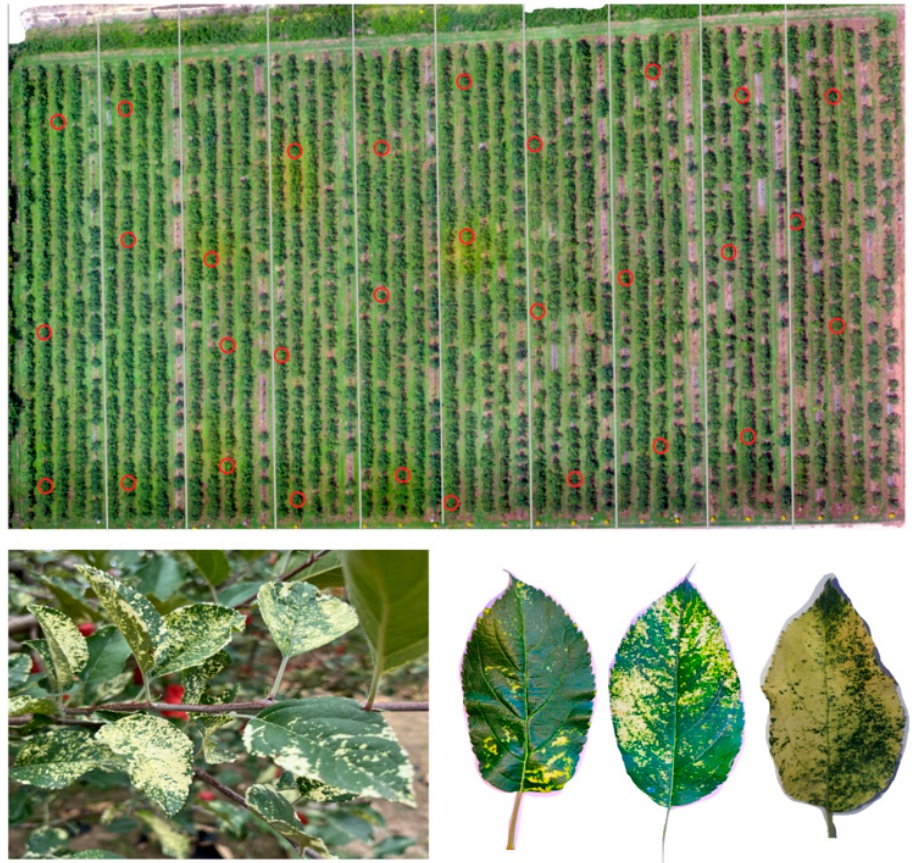
Figure 2. Sampling point location and Leaves of mosaic disease.